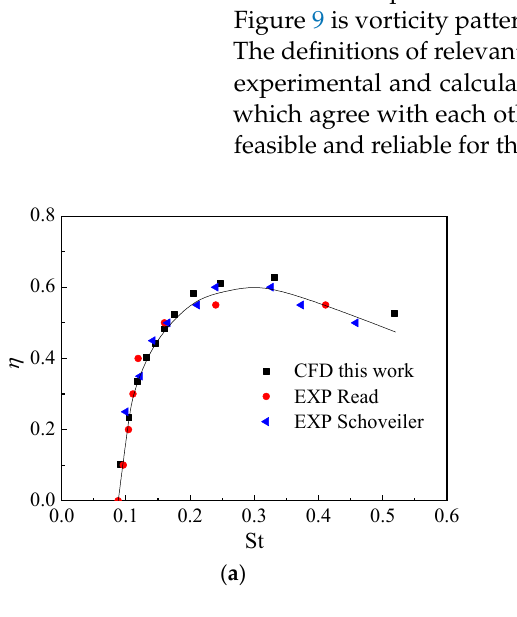
Figure 8. Comparisons of propulsive efficiency η and thrust coefficient c T with previous computa- tional and experimental results [42,43] (the black curve ■ is the CFD results of this paper; the red dot ● is the result of Read experiment; the blue triangle ▲ is the result of Schoveiler experiment). ( a ) Propulsive efficiency η . ( b ) Thrust coefficient c T .